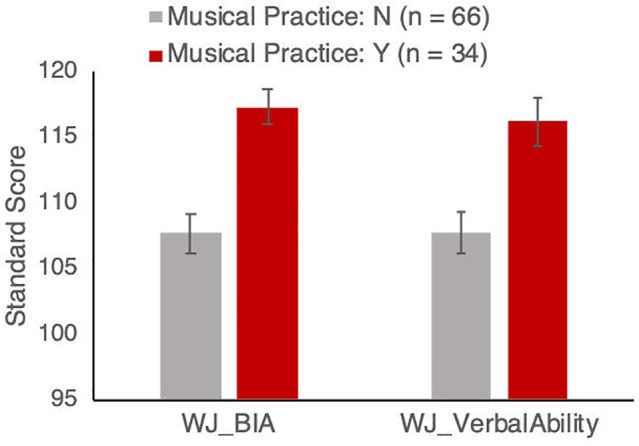
Woodcock-Johnson Brief Intellectual Ability (BIA) and Verbal Ability standardized scores for groups with and without musical instrument training. Results remain significant after controlling for age, sex, socio-economic status, and aerobic fitness, as described in the text. Error bars show between-subject standard error of the mean.